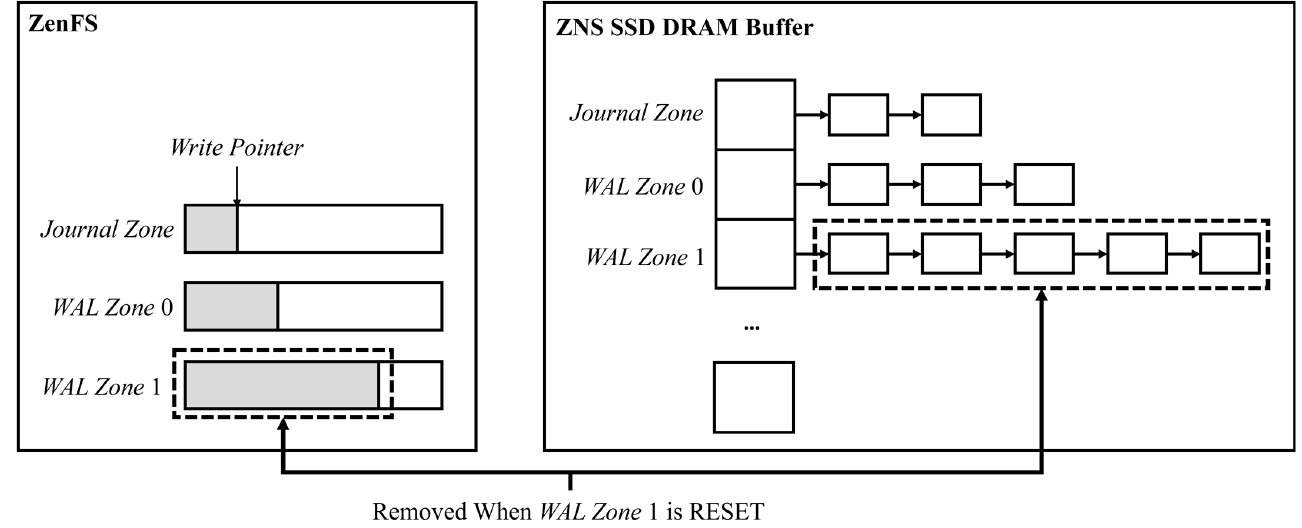
Figure 7. ZenFS optimization storing WAL and metadata in the PLP buffer.